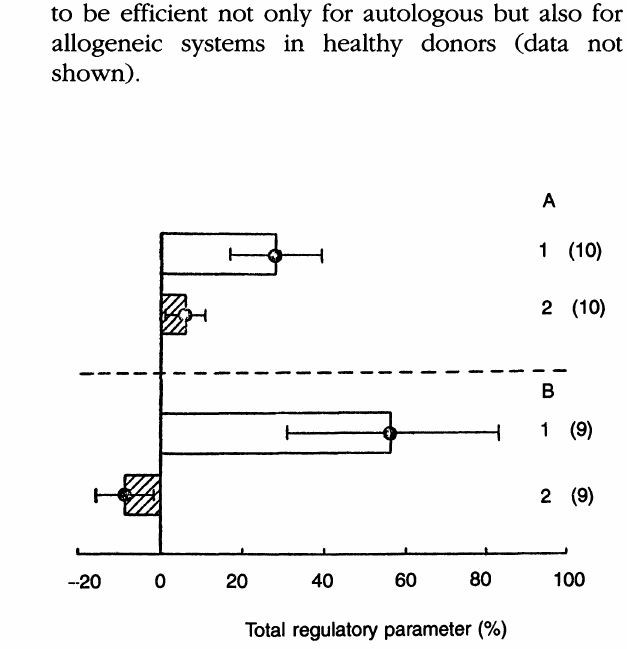
Fig. 2. Blockade of stimulatory actions of auto-IFN-x (A) and auto-IFN-7 (B) on NK activity of MS patients’ PBL by IFN-containing supernatants obtained from PBL of healthy donors. The probes of IFN-containing supernatants obtained from PBL of healthy donors in a volume of 0.1 ml were added to PBL suspensions of MS patients simultaneously with 0.1 ml of auto-IFN- containing probes for h at 37C followed by washing free of preparations and measurement of PBL NK cytotoxicity (2). Shading: p < 0.05 compared with TRP of auto-IFNs alone (1). The number of observations is displayed in parentheses. One observation corresponds to RP counted for one subject’s probe of